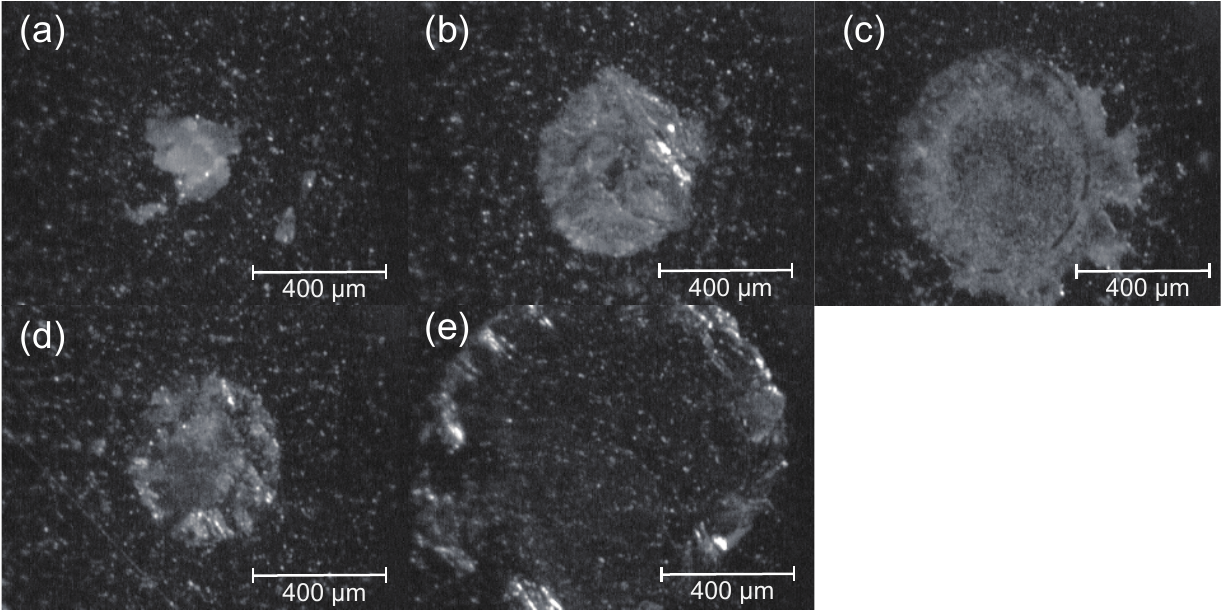
Figure 2. Snapshots of the morphological differences in each matrix system (0.25 µ L/spot) with SGP- 10 (5 pmol in 0.5 µ L/spot) spotted on the AnchorChip TM MALDI target plate: ( a ) BOA/DHB/Na (dried overnight at room temperature), ( b ) BOA HCl/DHB/Na (dried overnight at room temper- ature), ( c ) aniline/DHB/Na (dried overnight at room temperature), ( d ) NMA/DHB/Na (dried overnight at room temperature), and ( e ) DHB (0.1% TFA) (dried with a